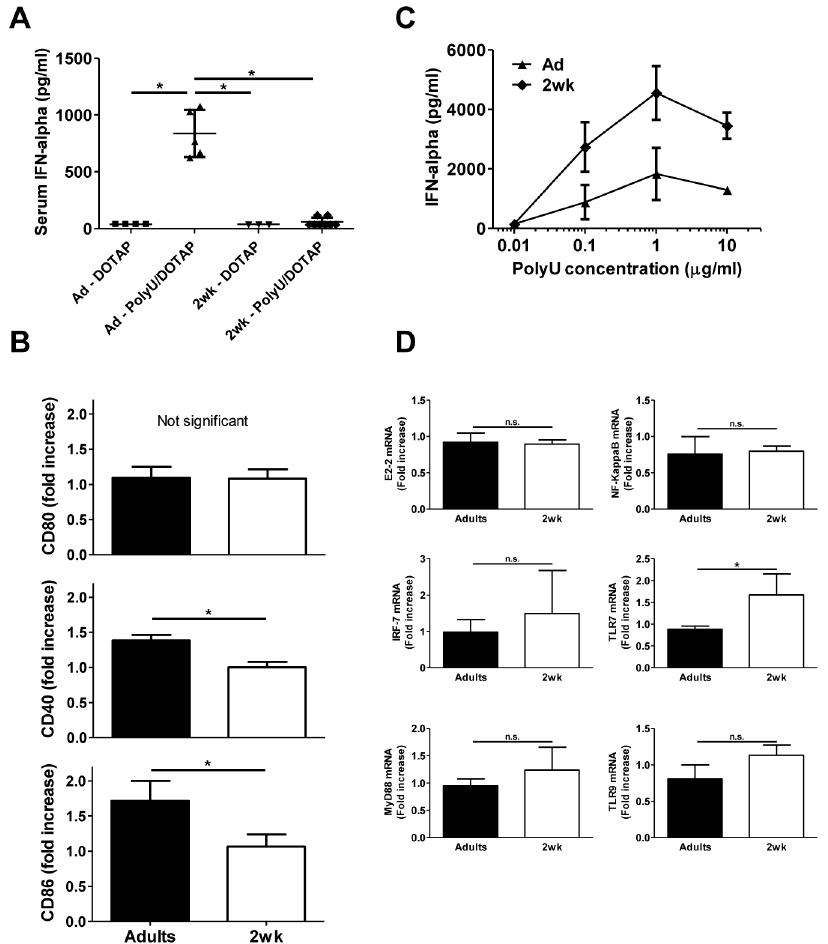
Figure 5. PolyU-stimulated function of infant pDCs is limited in vivo but not in vitro . (A) IFN-α titers quantified by ELISA in the serum 3h after i.v. injection of PolyU/DOTAP or DOTAP alone. One of two representative experiments is shown. *, p <0.05. (B) Fold increase of CD80, CD40 and CD86 expression by infant and adult splenic pDCs, determined by FACS staining between 0 and 3h after PolyU/DOTAP injection*, p <0.05. n = 5 to 8 mice per group. One of two representative experiments is shown. (C) Isolated untouched pDCs from infant or adult spleens were stimulated overnight with different concentrations of PolyU conjugated to polyethylenimine. Concentrations of IFN-α were tested in the supernatant by ELISA. n = 4 pools of 2 adult mice or 4 pools of 6 to 8 infant mice. One of two representative experiments is shown. (D) Expression of E2-2, IRF-7, MyD88, NF-κB, TLR7 and TLR9 mRNAs was analyzed by real-time RT-PCR in unstimulated and PolyU-stimulated (10μg/ml) splenic infant or adult pDCs. The results represent the fold increase derived from 3 independent experiments. n = 3 pools of 5 adult mice or 2 pools of 8 to 12 infant